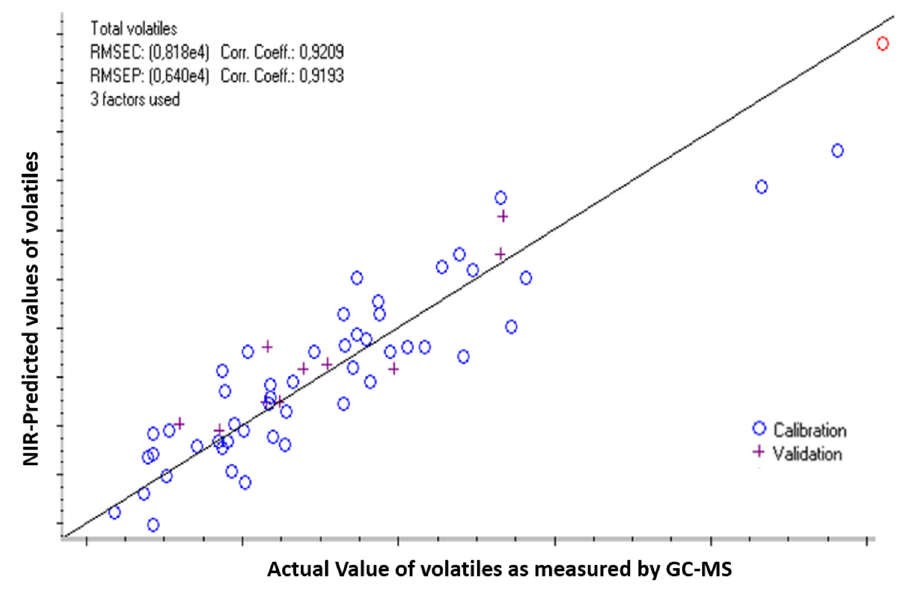
Figure 7. PLSR prediction model for lipid oxidation of infant milk formula using near-infrared spectroscopy (NIR).